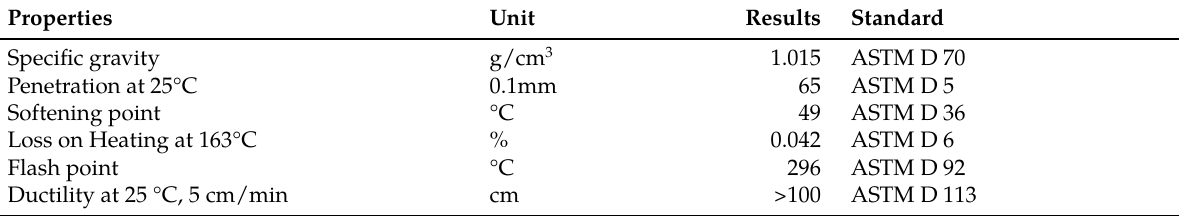
Table 3: Properties of bitumen penetration grade 60/70. Properties